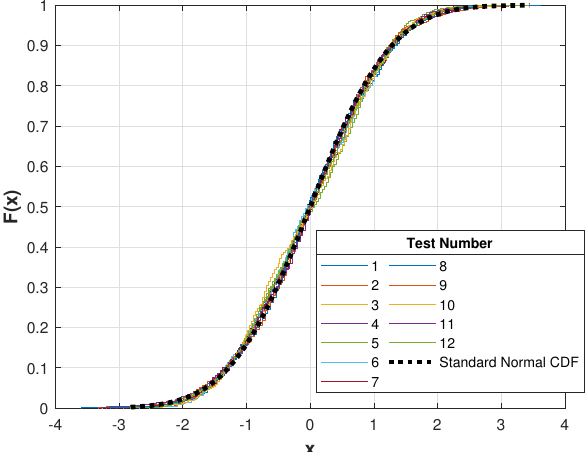
Figure 11. CDF for empirical